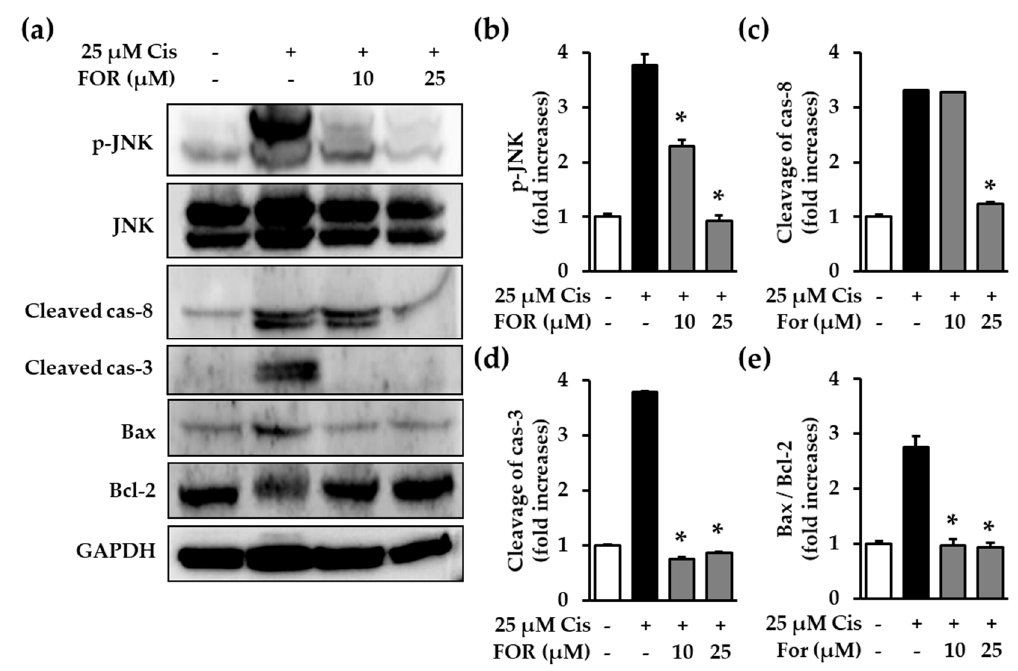
Figure 6. Formononetin inhibits caspase activation and Bcl-2 family-mediated apoptosis. Cells were treated with 25 μ M cisplatin in the presence of formononetin for 24 h. ( a ) Immunoreactive bands were detected using Western blot analysis; ( b – e ) immunoreactive bands were quantitatively analyzed for c-Jun N-terminal kinase (JNK) phosphorylation ( b ) and cleavage of caspase-8 ( c ), caspase-3 ( d ), and the ratio of Bax to Bcl-2 protein expression ( e ) (mean ± S.E.M., * p < 0.05 compared with cisplatin-treated cells).